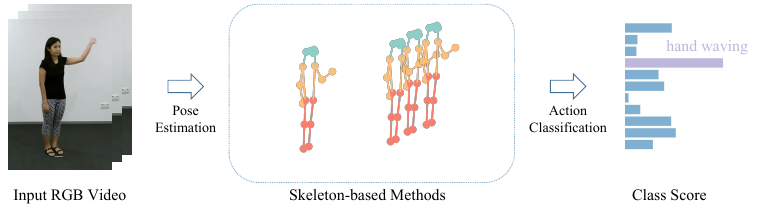
Figure 1. Skeleton-based methods most of the time represent skeletons in the form of graphs. It usually takes human joints as nodes, and human limbs as